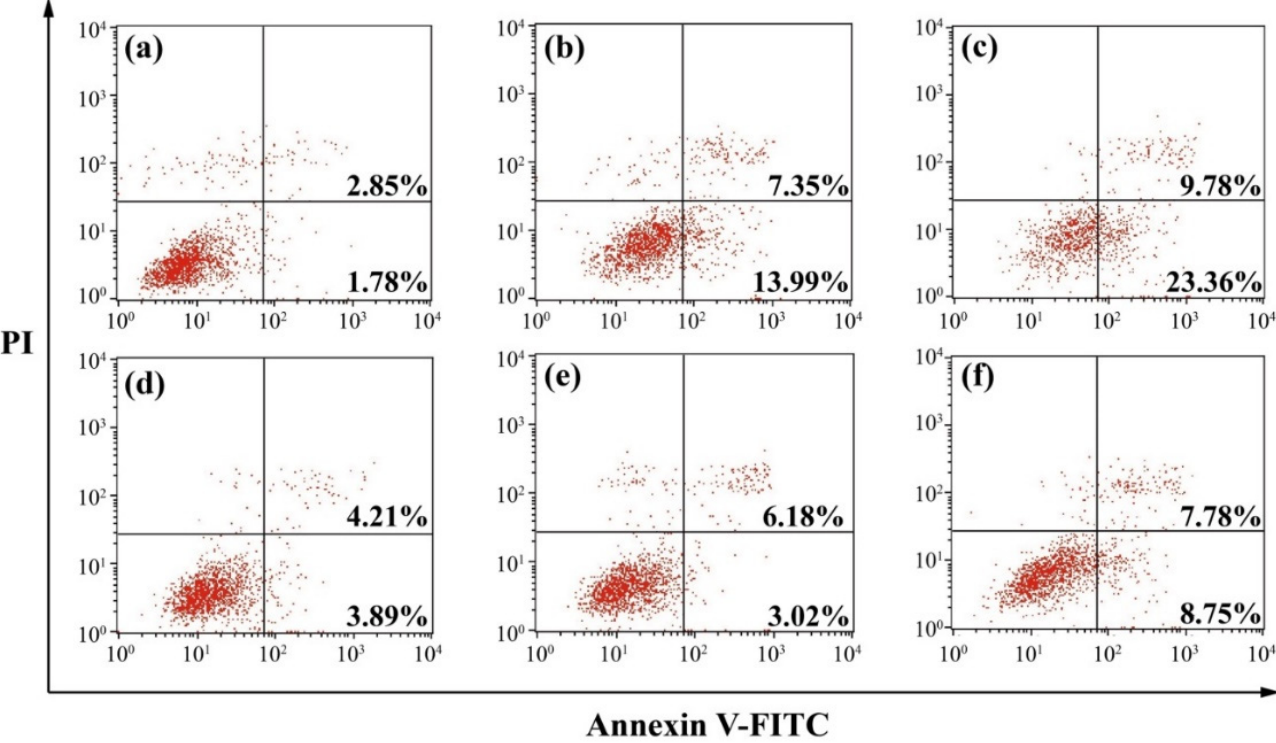
Figure 5. Cell apoptosis analysis after the miR-34a transfection. The transfected cells were stained with Annexin V-FITC and PI and analyzed by FACS: ( a ) control, ( b ) PEI/miR-34a, ( c ) LA-OEI/miR-34a, ( d ) OEI/miR-34a, ( e ) miR-34a, and ( f ) LA-OEI/N.C.